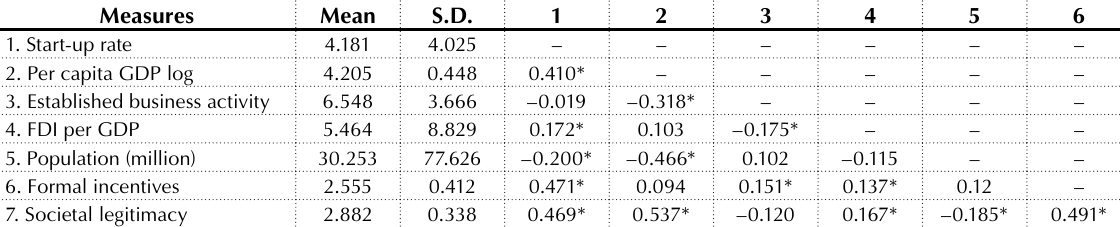
Table 1. Descriptive statistics and correlations (for unstandardized values)